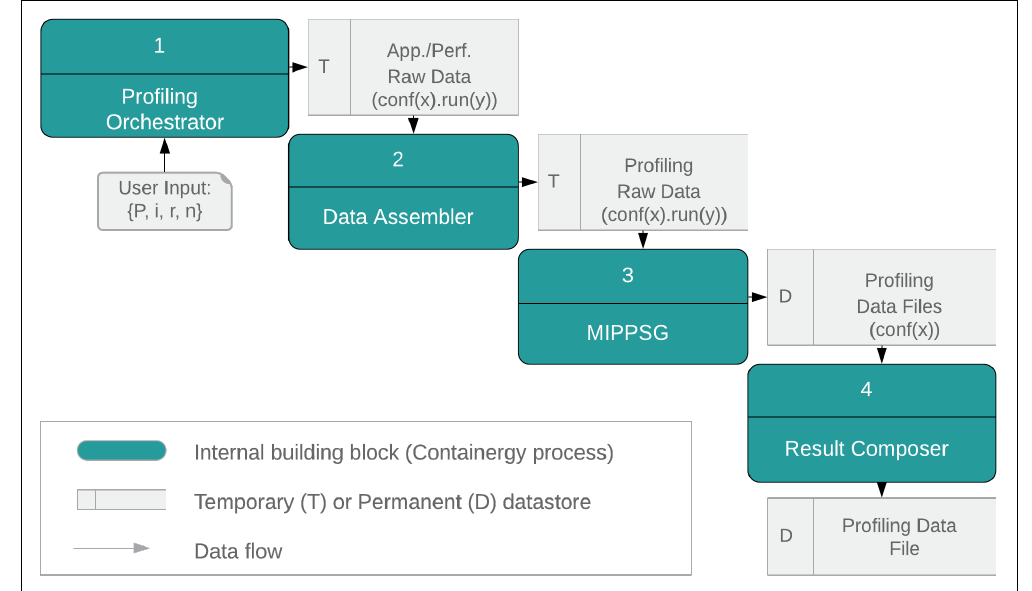
Figure 3. Containergy Data Flow